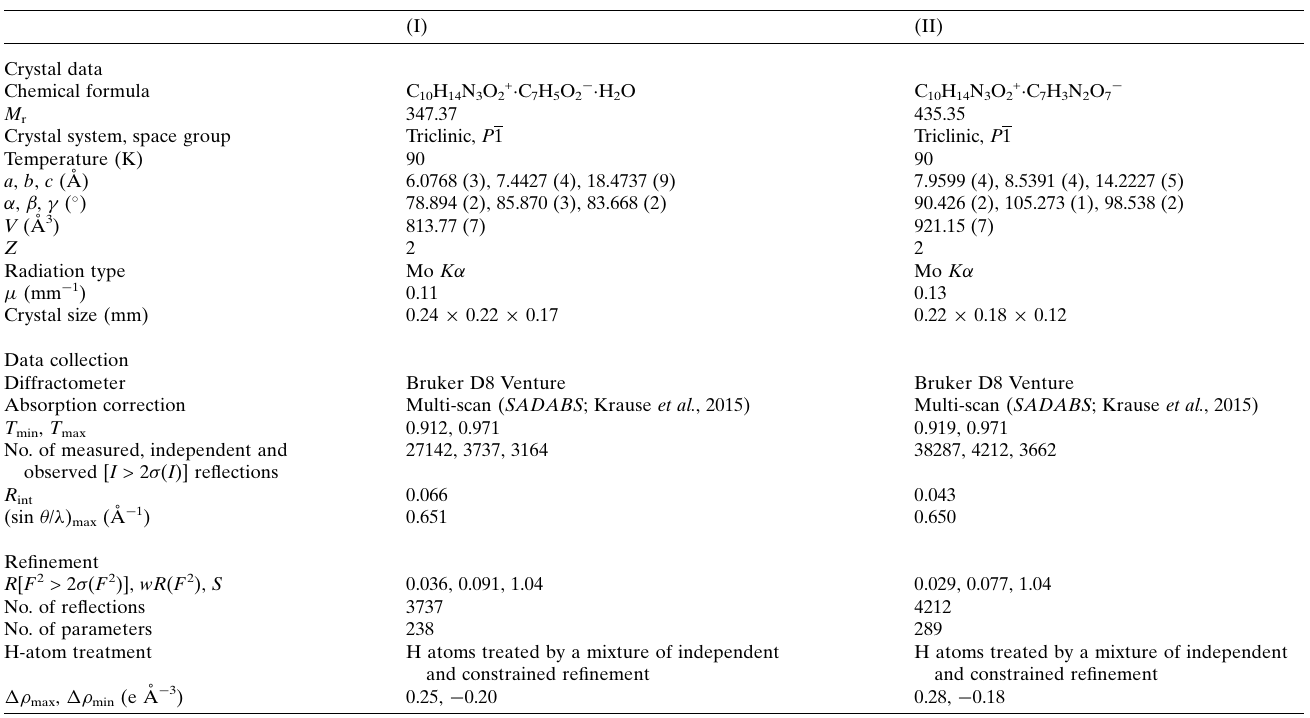
Table 3 Experimental details.